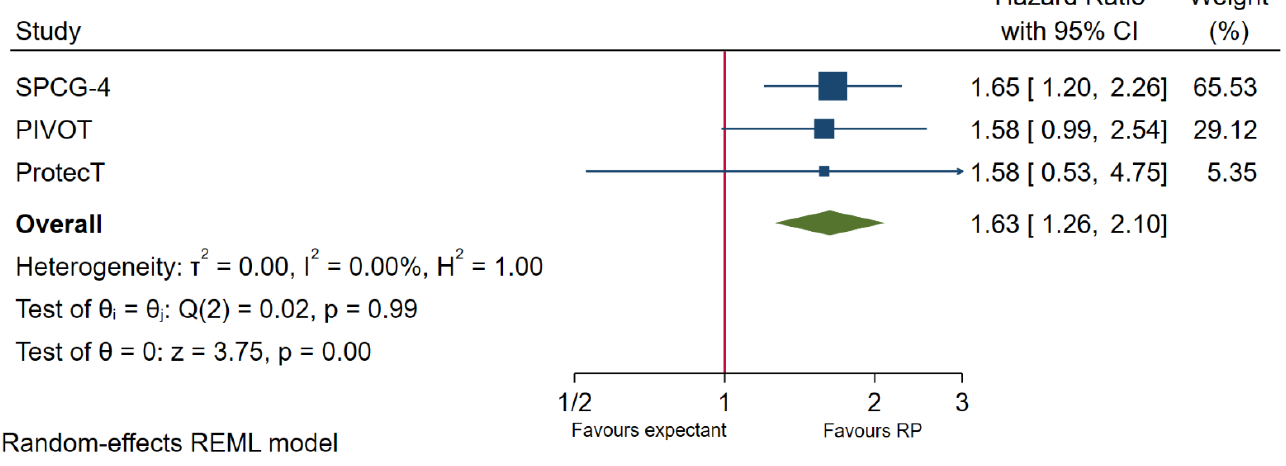
Figure 3. Cancer-specific survival in expectant management versus immediate RP.